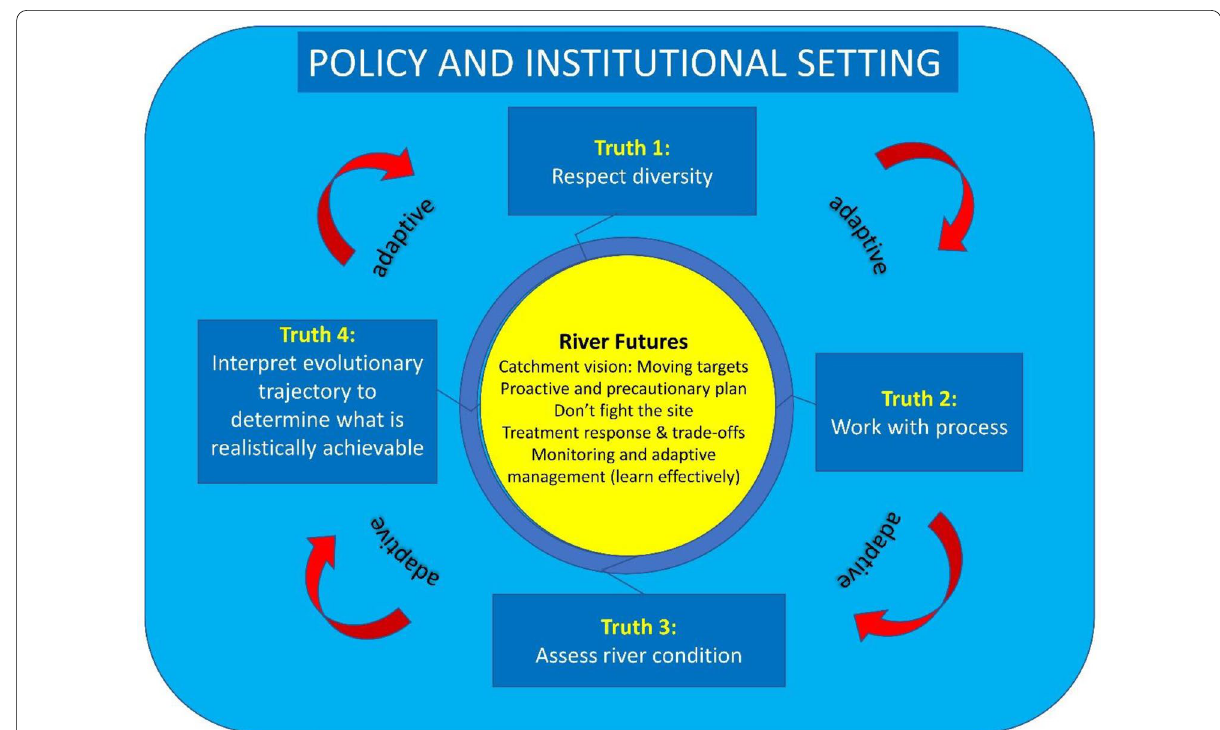
Fig. 8 Using lessons learnt from Truths of the Riverscape to determine what is realistically achievable in proactive and precautionary catchment management